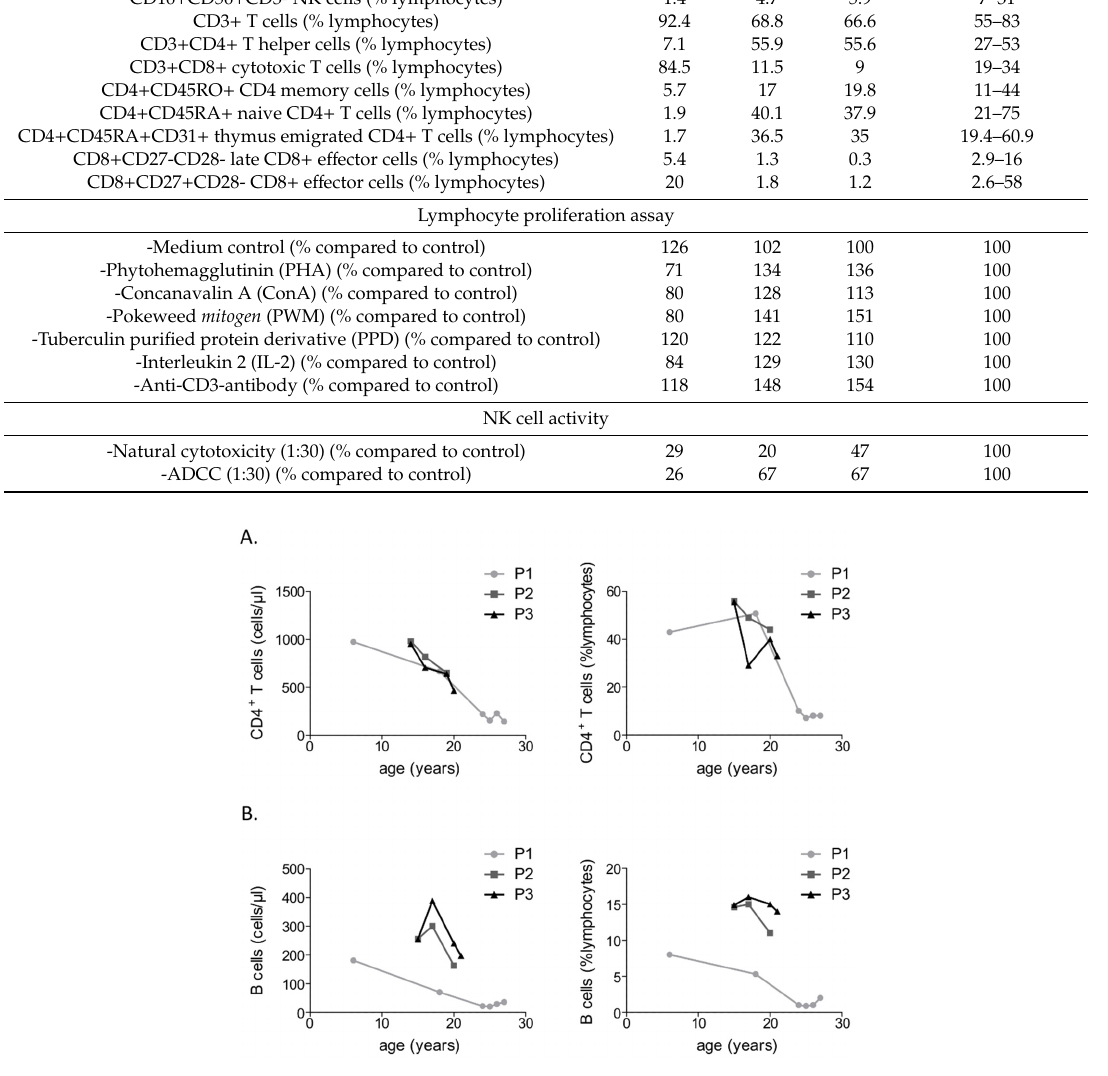
Figure 2. Progressive depletion of CD4 + T cells ( A ) and CD19 + B cells ( B ) in three patients with ICF2.